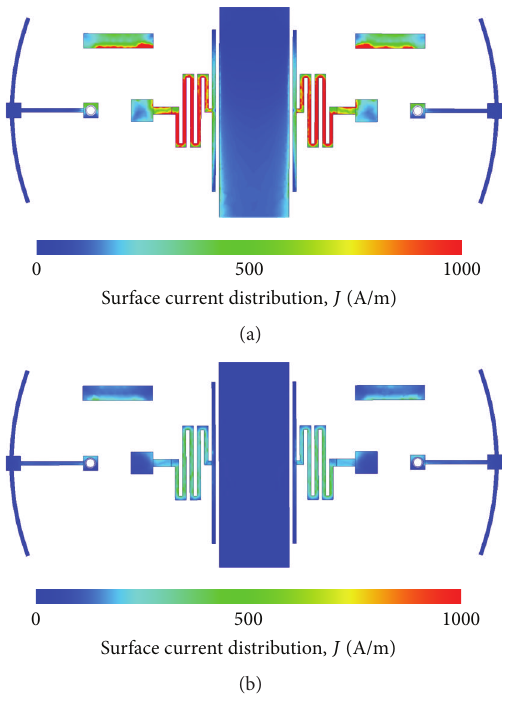
Figure 4: Distribution of the surface current on the feedline and the band-notched structure: (a) at 4.2GHz when the state of PIN diodes is ON and bias voltage is 0V; (b) at 5.8 GHz when the state of PIN diodes is OFF and bias voltage is 0V.